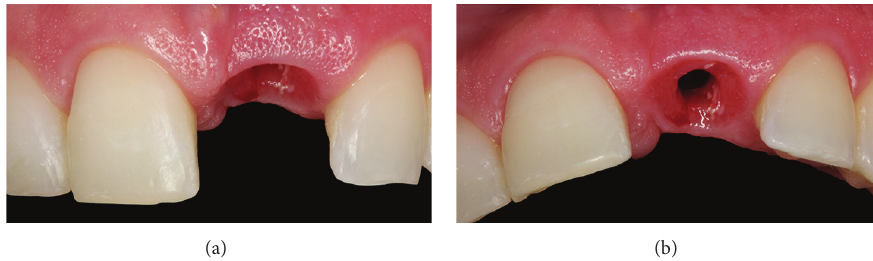
Figure 10: The gingival color, texture, and contour appeared similar to the adjacent soft tissues of the